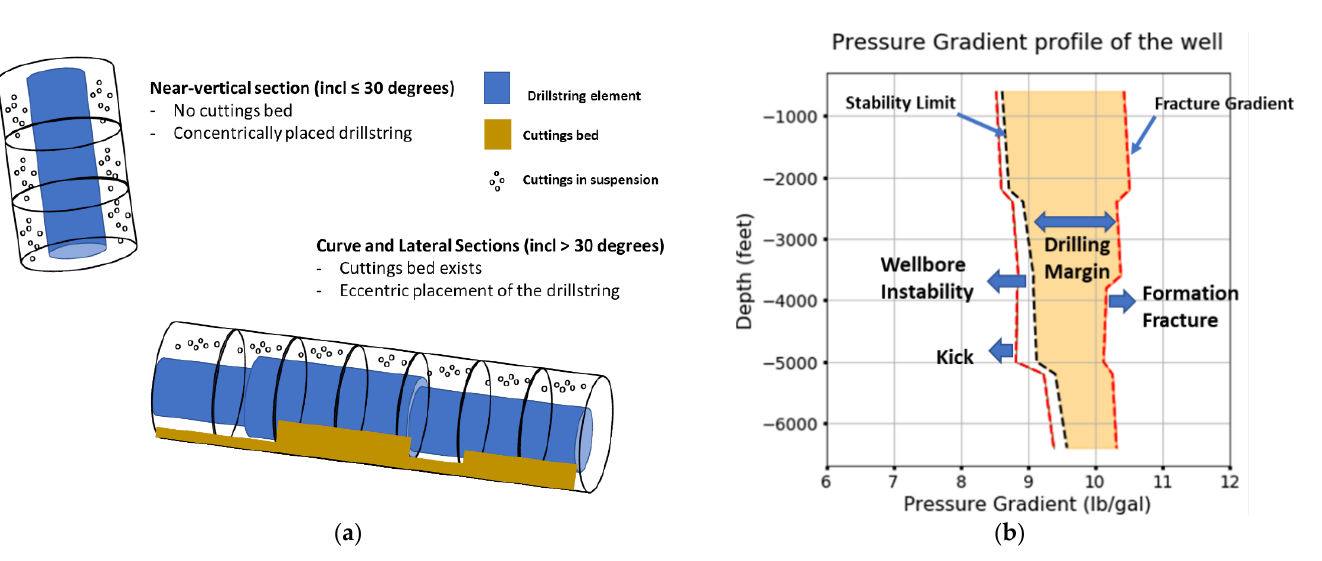
Figure 5. ( a ) Cuttings bed height in different inclination intervals for the well ( b ) Drilling